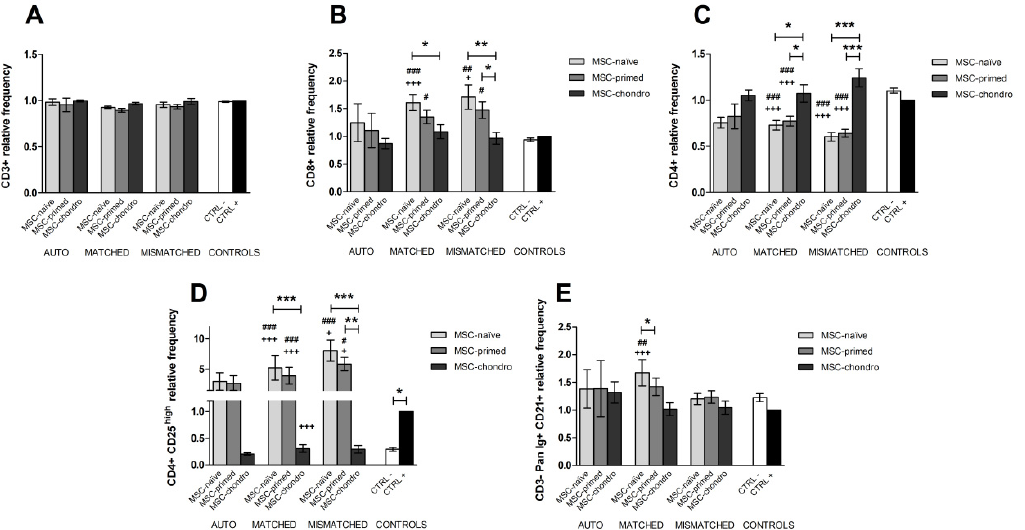
Figure 3. Mean ± SEM of the relative frequency of different lymphocyte subsets in the immunomod- ulatory assays: ( A ) CD3+ T lymphocytes, ( B ) CD8+ cytotoxic T cells, ( C ) CD4+ helper T cells, ( D ) CD4+ CD25 high regulatory T cells, ( E ) CD3 − Pan-Ig+ CD21+ B cells. Phytohemagglutinin (PHA)-activated PBLs were exposed in vitro to MSC-naïve (light grey bar), MSC-primed (medium grey bar) and MSC-chondro (dark grey bar). Co-cultures of MSCs and PBLs were autologous ( n = 3) or allogeneic, matched ( n = 8) or mismatched ( n = 7) for the MHC. Data from each PBL donor is nor- malised over the positive control (CTRL+) consisting of PHA-stimulated PBLs alone from the same donor (value 1), to account for inter-individual variability. Significant differences of each condition over the CTRL+ (black bar) are represented by a cross (+) above the corresponding bar (+ = p < 0.05; +++ = p < 0.001). Significant differences over the negative control (CTRL − ; non-activated PBLs alone, white bar) are represented by hashes (#) above the corresponding bar (# = p < 0.05; ## = p < 0.01; ### = p < 0.001). Significant differences between experimental conditions are represented by a squared line with an asterisk (* = p < 0.05; ** = p < 0.01; *** = p <